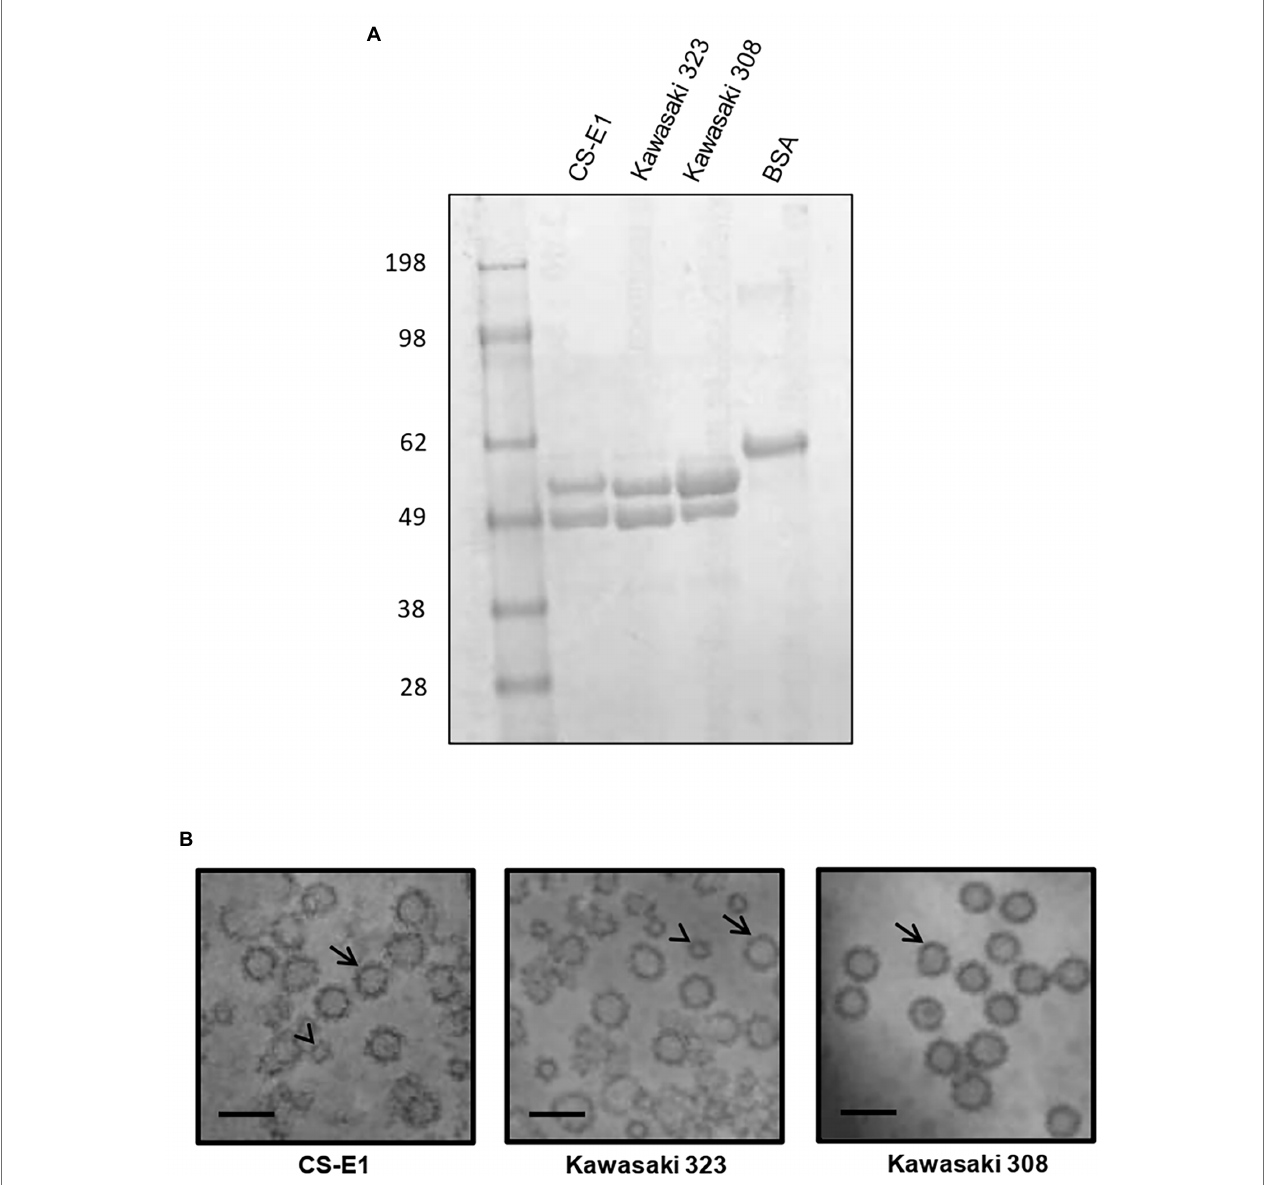
FIGURE 2 | Virus-like particle (VLP) production. (A) Two micrograms of purified VLP were resolved on NuPAGE gel in denaturing conditions using MOPS buffer following manufacturer’s recommendations (Life technologies, France). The origin of each sample is indicated above the gel. Molecular weight markers are indicated on the left side of the gel. (B) Transmission electron microscopy images of GII.17 VLP preparations from scanning transmission electron microscopy. VP1 160 ( T = 3) and VP1 60-80 —like VLPs ( T = 1) are indicated by arrow and arrowhead, respectively. Variants are indicated below each picture. The scale bar on each micrograph represents 50